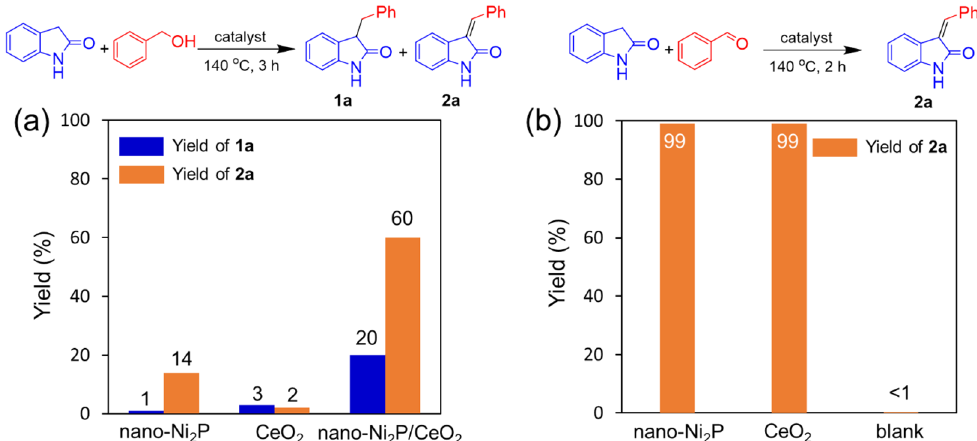
Figure 4. Control experiments for ( a ) the C-3 alkylation of oxindole with benzyl alcohol, and ( b ) the aldol-type condensation of oxindole with benzaldehyde. Reaction conditions: nano-Ni 2 P (4.3 mg), CeO 2 or nano-Ni 2